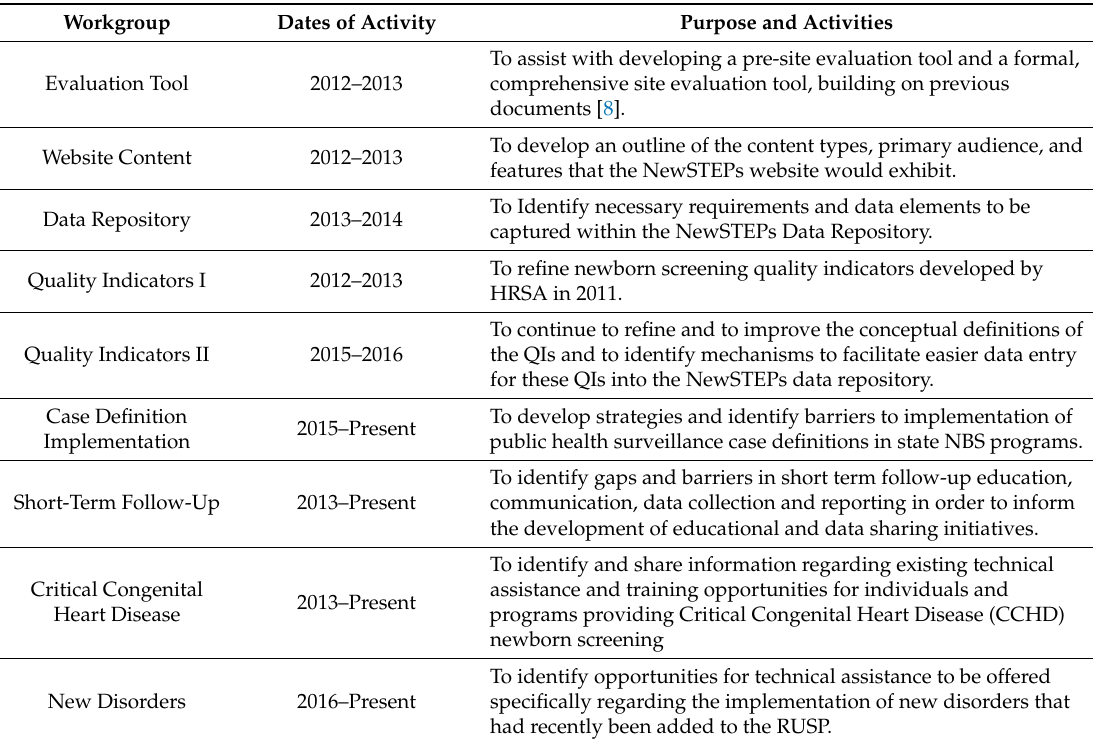
Table 1. Newborn Screening Technical assistance and Evaluation Program (NewSTEPs) Workgroups